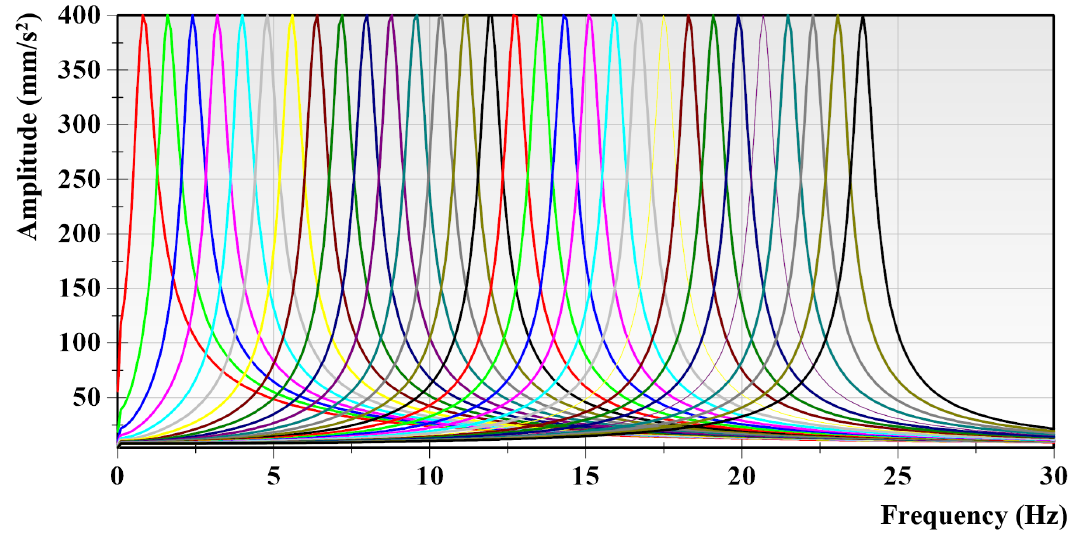
Figure 3: The spectral amplitude characteristic of harmonic signals used in FEM dynamic